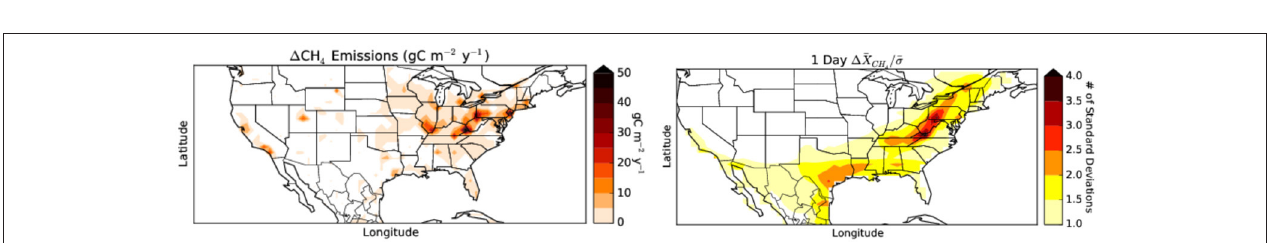
FIGURE 6 | (Left) Difference between 2011 and 2012 emissions for August, which demonstrates the enhanced source in 2012 north of the Amazon, and diminished source south of the Amazon, according to MACC. (Right) The resulting gridded differences in X CH4 as would be seen from GeoCarb, averaged over 10 days and scaled by the uncertainty. After 10 days, a detectability threshold of 3 standard deviations is achieved for the northern region, and 1–2 standard deviations for the southern region. Longer averaging times of ∼ 20 days led to greater detectability due to daily sampling, even in the presence of clouds.